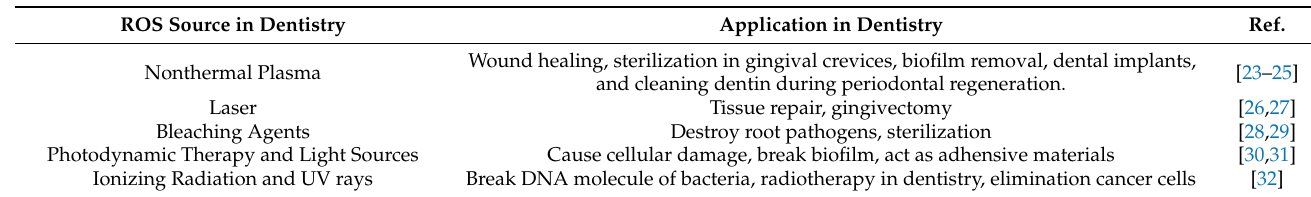
Table 1. Source of reactive oxygen species (ROS) in